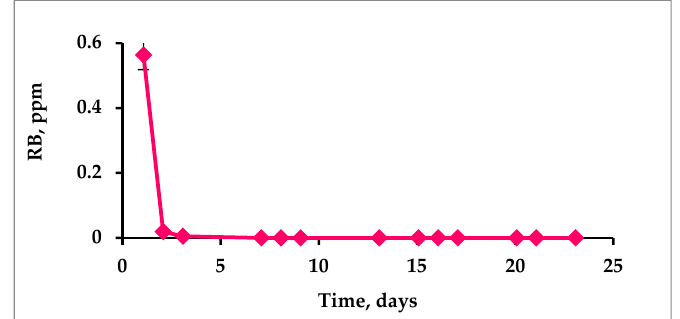
Figure 2. Leakage of RB in continuous washing of RB/PE by tap water. A total of 260 g of RB/PE as loaded in a bath with 1.5 L of tap water and washed by it at a flow rate of 2 mL/min under illumination with 1.25 mW/cm 2 white light.